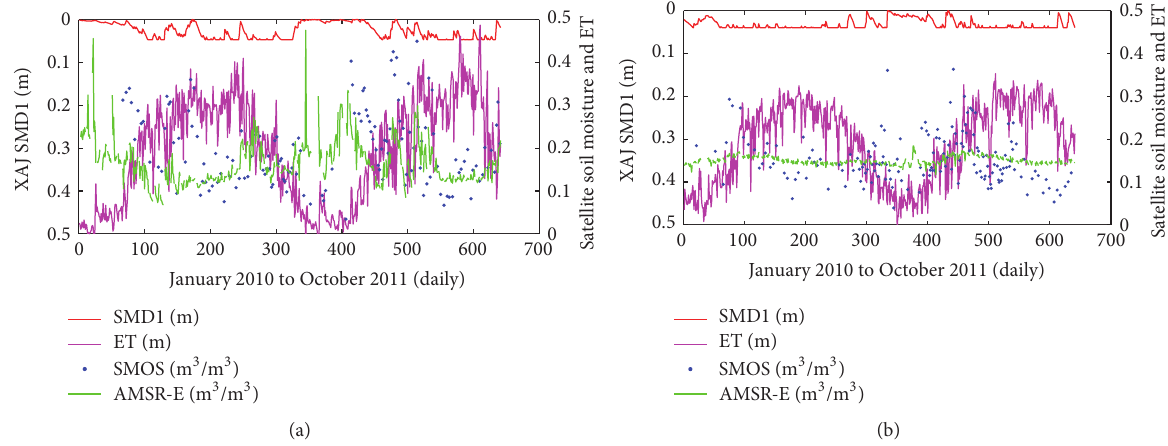
Figure 4: Comparisons among actual ET, SMD1, SMOS, and AMSR-E for PB (a) and for FBB (b); ET shown here is scaled down to 1/40 of its original